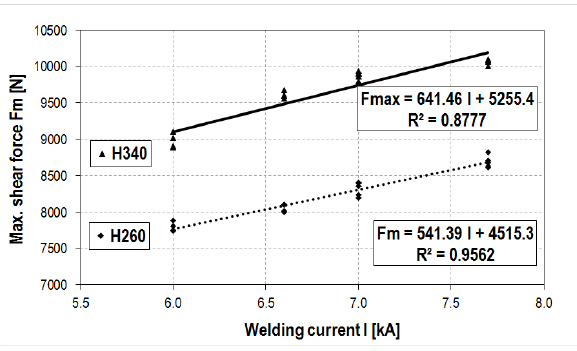
Figure 2: Dependency of load-bearing capacity of spot welds Fm on welding current I.